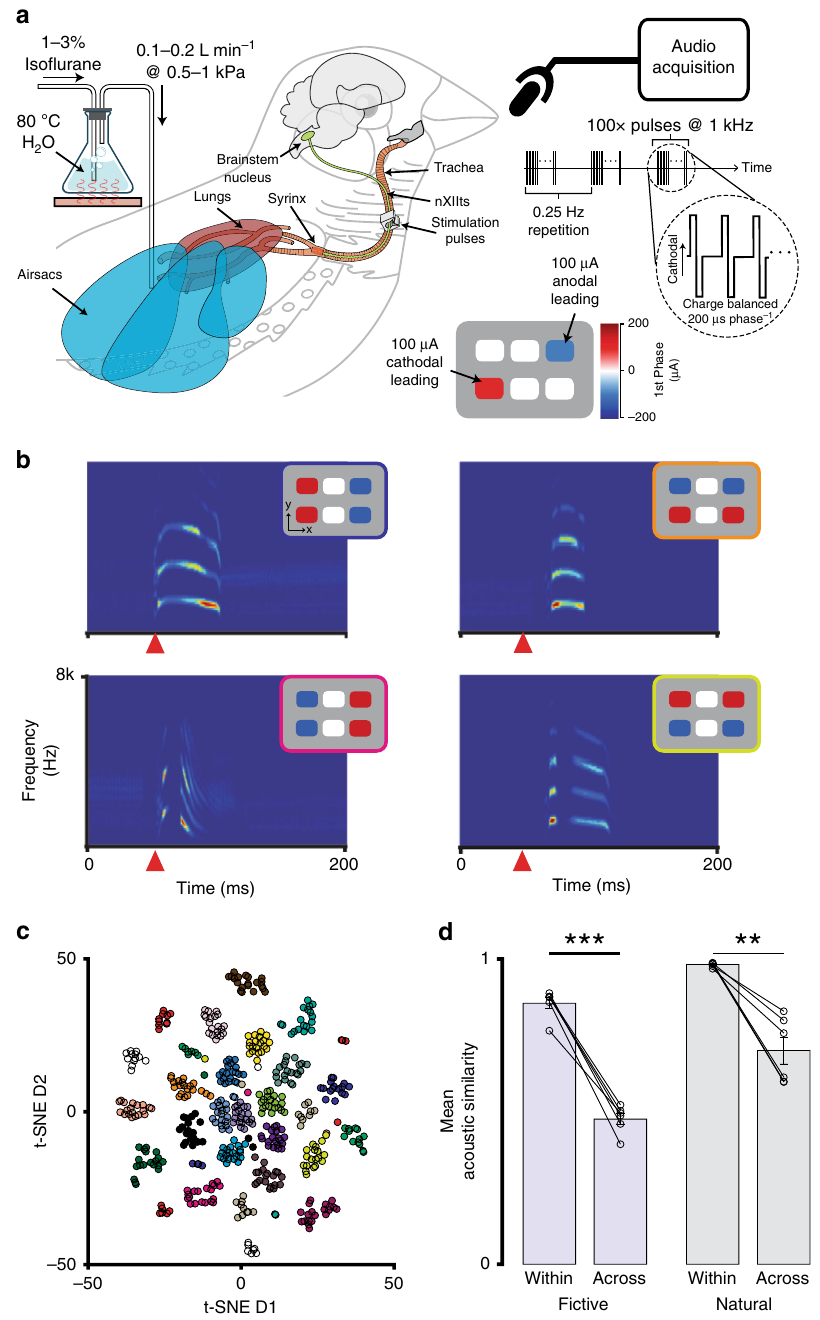
Fig. 7 Multichannel stimulation in a small volume can achieve functional modulatory speci fi city. a In vivo experimental setup for current-steering-evoked fi ctive singing. The nanoclip was implanted on the right-side nXIIts of an anesthetized adult male zebra fi nch, and an air cannula was placed in the abdominal air sac (see “ Methods ” ). The respiratory system was pressurized by fl owing warmed and humidi fi ed (35 C; 80%) iso fl urane dissolved in oxygen through the cannula (0.1 – 0.2 L min − 1 at 0.5 – 1.5 kPa). Multichannel stimulation (100 biphasic current pulses at 1 kHz, 200 μ s phase − 1 ) with unique spatial patterns was applied to the nXIIts with the nanoclip interface, eliciting audible vocalizations that were recorded via a microphone. b Representative examples of current-steering-elicited fi ctive vocalizations. For each pairing, the inset (upper right of each spectrogram) identi fi es the stimulation pattern that produced the vocalization shown in the spectrogram. Each spectrogram depicts the vocalization from a single trial; the orange triangle marks the onset of stimulation. c Two-dimensional t-SNE embedding of high-dimensional representations of fi ctively produced vocalizations (i.e., spectrograms) from one experiment testing 24 distinct current-steering stimulation patterns. Data points correspond to individual stimulation trials; colors denote current-steering patterns (see Supplementary Fig. 7 for pattern de fi nitions). d (Left) Mean acoustic similarity between fi ctive vocalizations within and across multichannel stimulation patterns for n = 6 birds. (Right) Mean acoustic similarity between natural vocalizations within and across song syllable types for n = 6 birds. In each, data points show mean across vocalizations within a bird. Bars show mean across all birds in each experiment; error bars indicate sem. Two-tailed, paired t -test, within: P = 3.5 × 10 − 5 ; across: P = 0.0016. ** P < 0.01; *** P < 0.001 Source data are provided as a Source Data